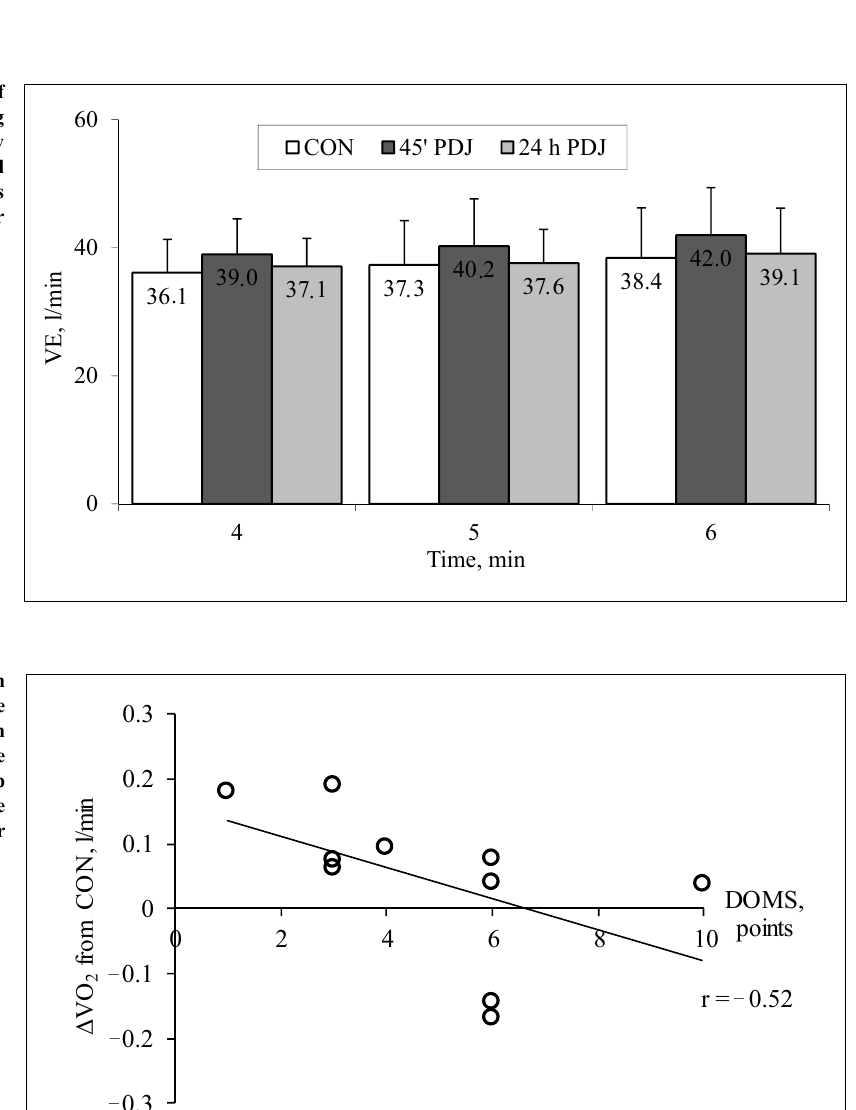
Note. Values are means (SD).